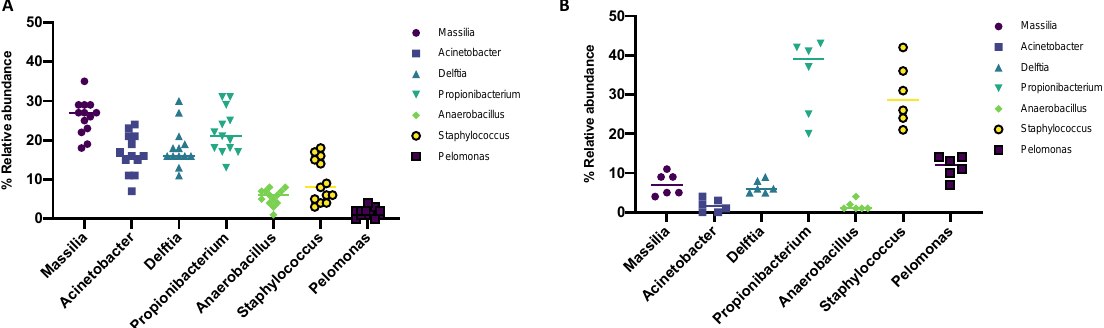
Figure 1. ( A ) Phylum of conjunctival samples performed at birth and ( B ) after antibiotic prophylaxis ( p -value < 0.0001).